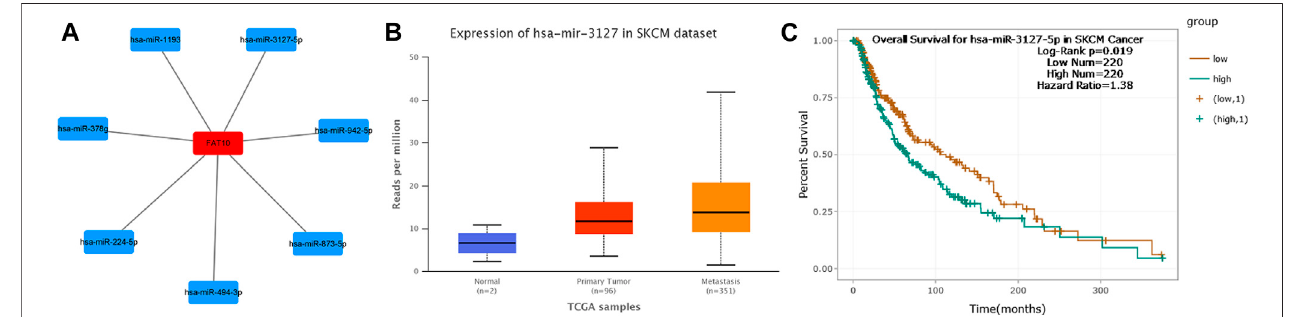
FIGURE 4 | Identify hsa-miR-3127-5p as a potential upstream miRNA of FAT10 in SKCM. (A) The miRNA-FAT10 regulatory network was established via cytoscapesoftware. (B) Theexpression ofhsa-miR-3127-5p inSKCMandcontrolnormalsamplesviaUALCANanalysis. (C) Theprognosticvalueofhsa-miR-3127-5p in SKCM assessed by starBase database.